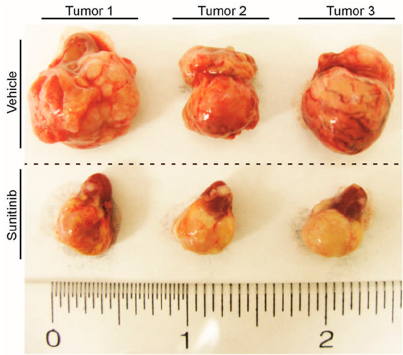
Figure 1. Antiangiogenic resistant tumors. Murine renal cancer tumors were generated by orthotopic injection of RENCA cells in Balb/C mice. Displayed tumors were obtained from mice treated with vehicle (distilled water with 1.8% NaCl, 0.5% carboxymethylcellulose, 0.4% tween 80 and 0.9% benzylalcohol, pH: 6.0) or Sunitinib (40 mg/kg, five days a week) for 17 days. Tumors were established for 10 days before treatment. All animal protocols were approved by the institutional bioethics committee at Universidad Andres Bello, Santiago, Chile. Approval #024/2014 (26 December 2014).